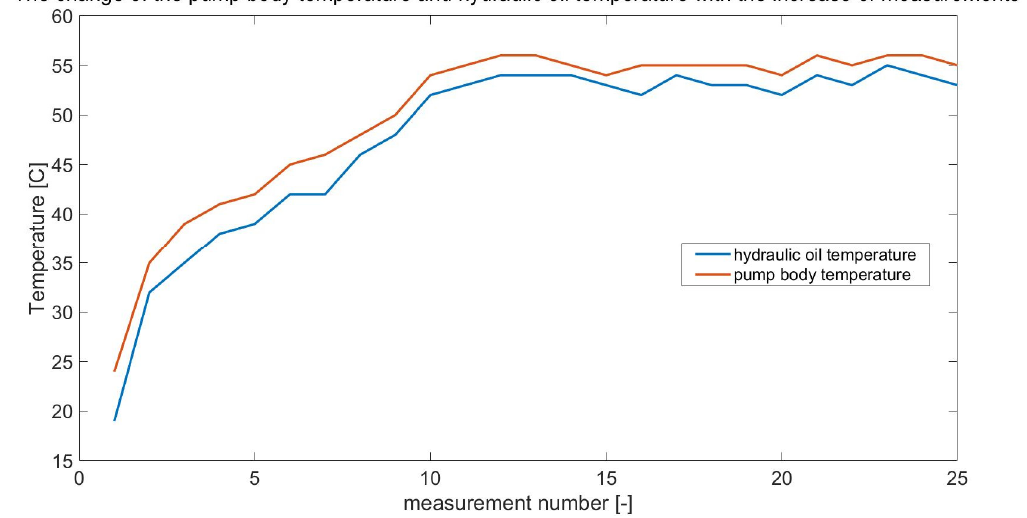
Figure 5. The change in the pump body temperature and hydraulic oil temperature with the increase in measurements.